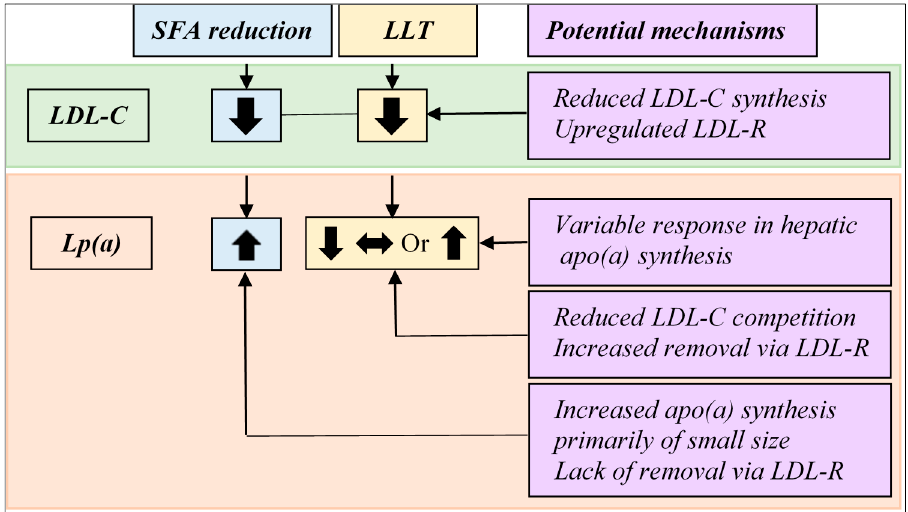
Figure 2. Effect on LDL-C vs. Lp(a) by lowering of dietary saturated fat intake vs. lipid-lowering therapy and potential underlying mechanisms. While both lipid-lowering therapy (LLT) and reduction in dietary saturated fatty acid (SFA) intake lower plasma LDL-C concentrations, their effects on Lp(a) vary. Lowering dietary SFA intake has been associated with a modest increase in Lp(a) concentration. The e ff ect of existing LLT on Lp(a) concentration is heterogeneous. Statins induce either an increase or a reduction, whereas inhibitors of CETP or PCSK9 have been associated with decreases in Lp(a). Lp(a) plasma concentration is primarily regulated by apo(a) synthesis in the liver and the role of LDL receptor (LDL-R) in Lp(a) metabolism remains incompletely